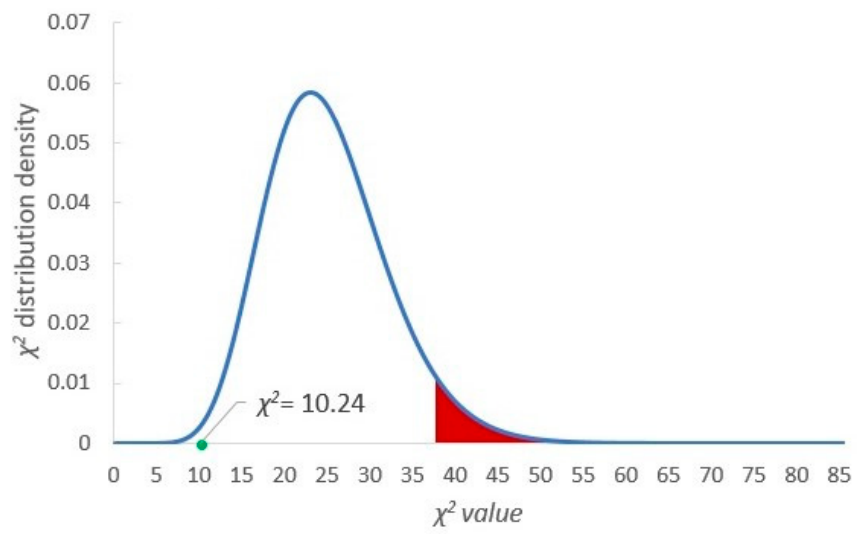
Figure 1. Pine needle moisture content plots.